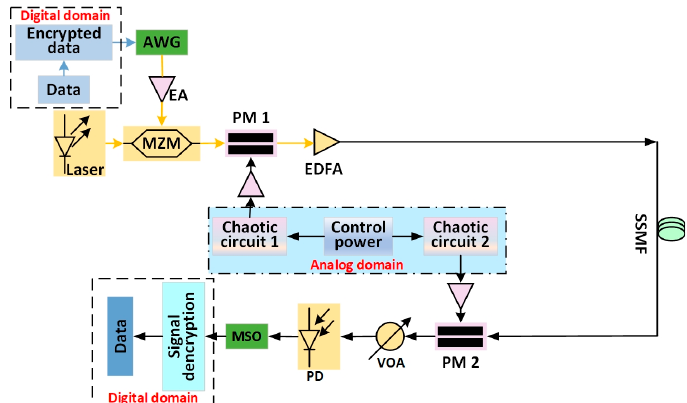
Figure 9. Experimental setup (AWG: arbitrary waveform generator; MZM: Mach–Zehnder modulator; EDFA: erbium-doped fiber amplifier; PM: phase modulator; VOA: variable optical attenuator; PD: photodiode; MSO: mixed signal oscilloscope).